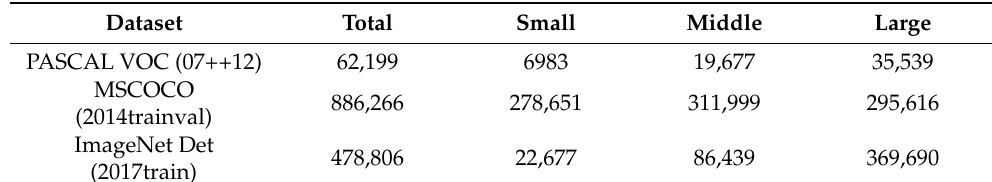
Table 1. Comparisons of open-source datasets.